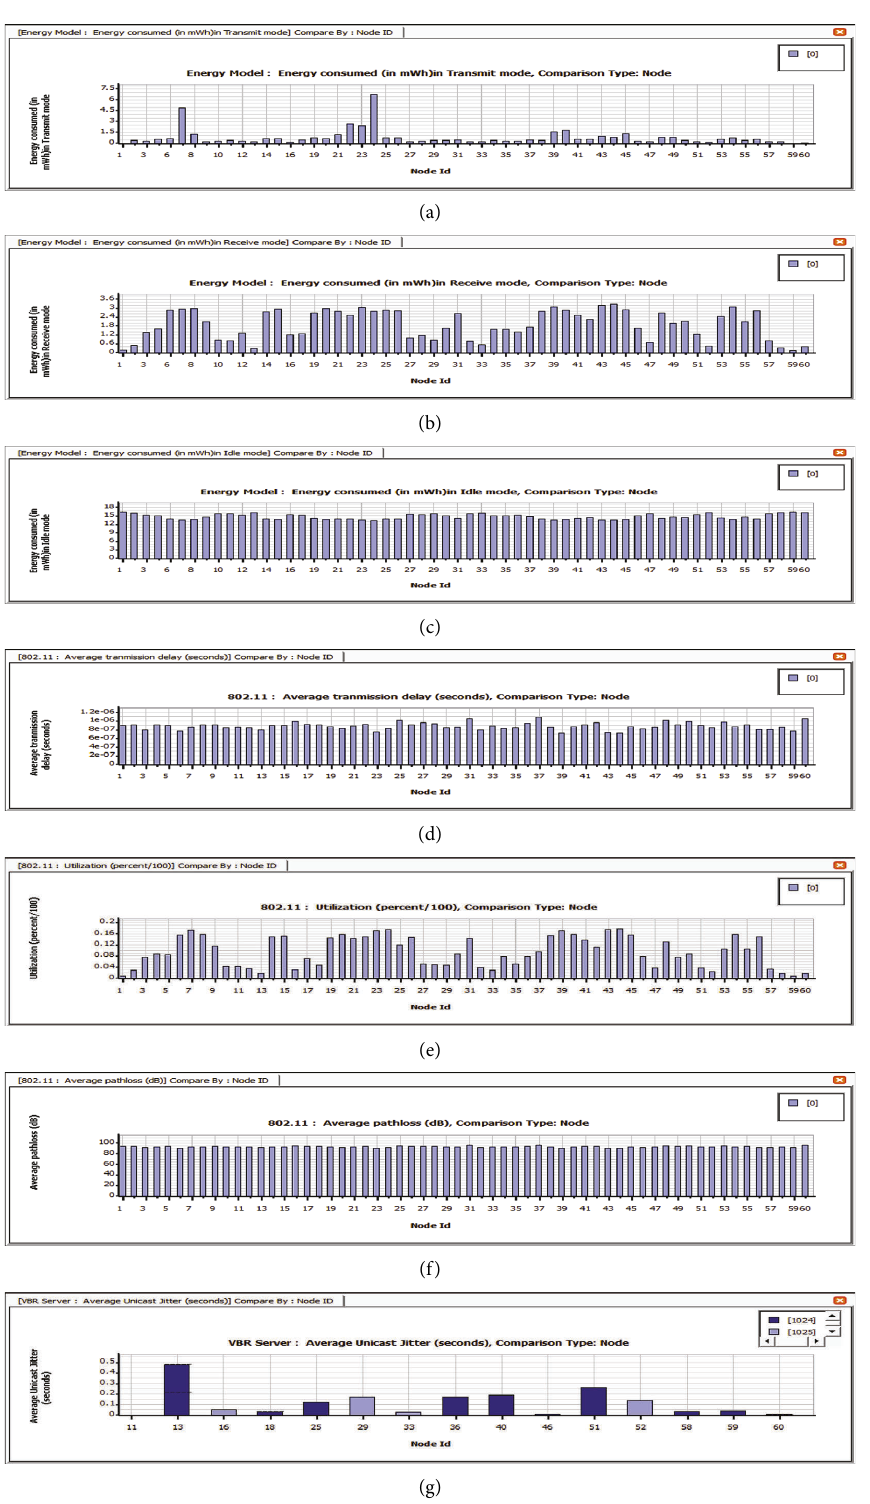
Figure 27: (a) Transmit mode energy consumption of ZRP for VBR deployment. (b) Receive mode energy consumption of ZRP for VBR deployment. (c) Idle mode energy consumption of ZRP for VBR deployment. (d) Average transmission delay of ZRP for VBR deployment. (e) Percentage utilization of ZRP for VBR deployment. (f) Average pathloss of ZRP for VBR deployment. (g) Average jitter of ZRP for VBR